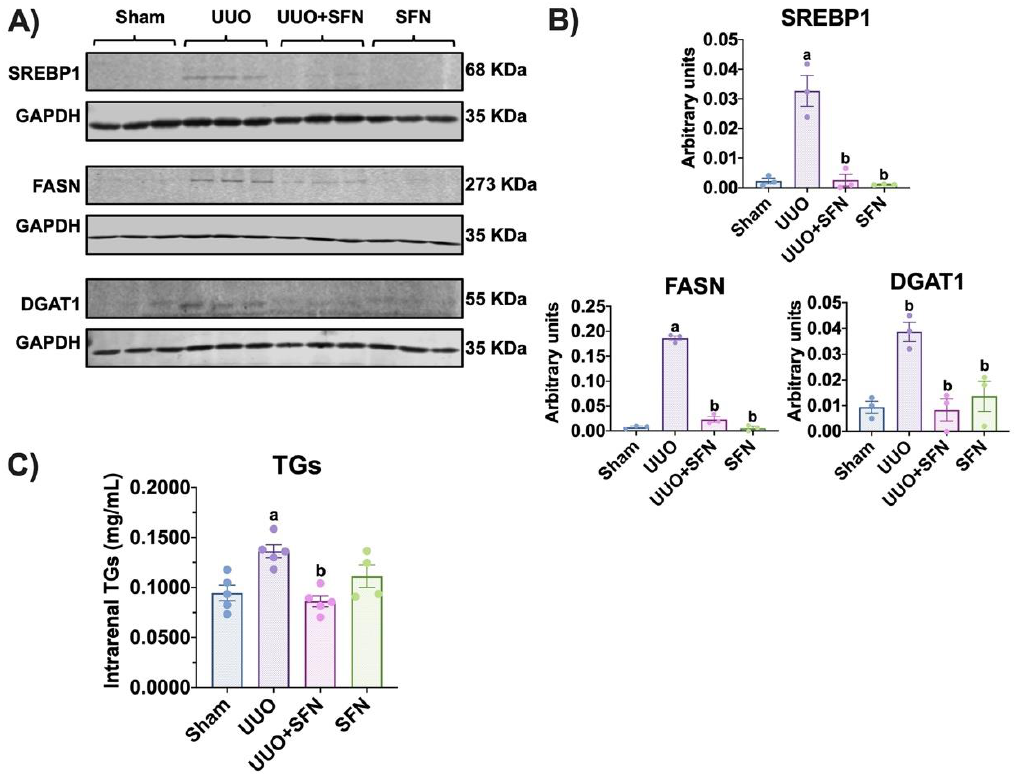
Figure 9. Effect of sulforaphane (SFN) on lipid synthesis in the unilateral ureteral obstruction (UUO) model. ( A ) Representative immunoblotting and ( B ) densitometric analysis of sterol regulatory-ele- ment binding proteins (SREBP1), fatty acid synthase (FASN), and diacylglycerol O-acyltransferase